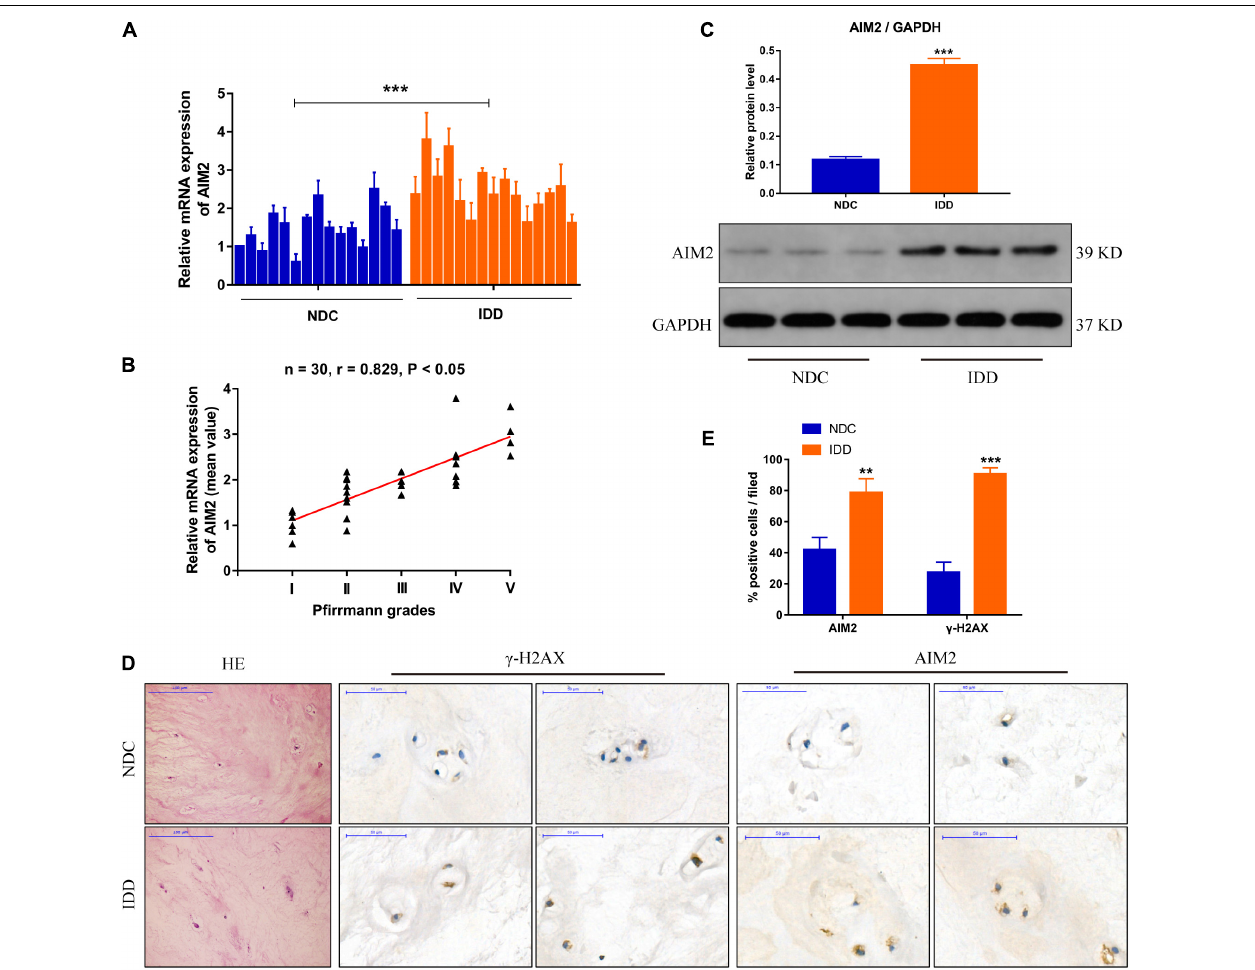
FIGURE 1 | AIM2 expression in human intervertebral disc tissues. (A) AIM2 mRNA level measured by qRT-PCR in non-degenerative NP tissues (NDC) and degenerative NP tissues (IDD), n = 15. (B) Correlation analysis between the mean AIM2 mRNA level and Pfirrmann grades of NDC and IDD tissues. (C) Represent western blot image and quantification of AIM2 protein expression in human NDC and IDD tissues. GAPDH was used as an internal control. (D) HE staining and immunochemistry staining of γ -H2AX and AIM2 in human NDC and IDD tissues. (E) Quantification rate of AIM2 and γ -H2AX positive cells. Data were presented as the means ± SD, n = 3. ** P < 0.01, *** P < 0.001 vs. NDC